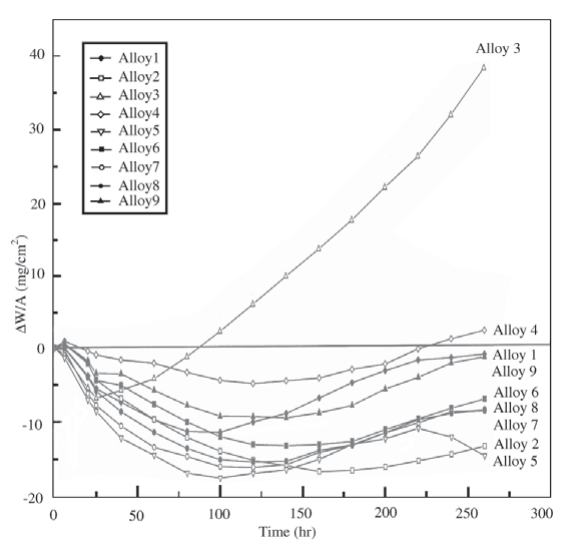
Figure 4. Weight change kinetics during cyclic oxidation 5 .